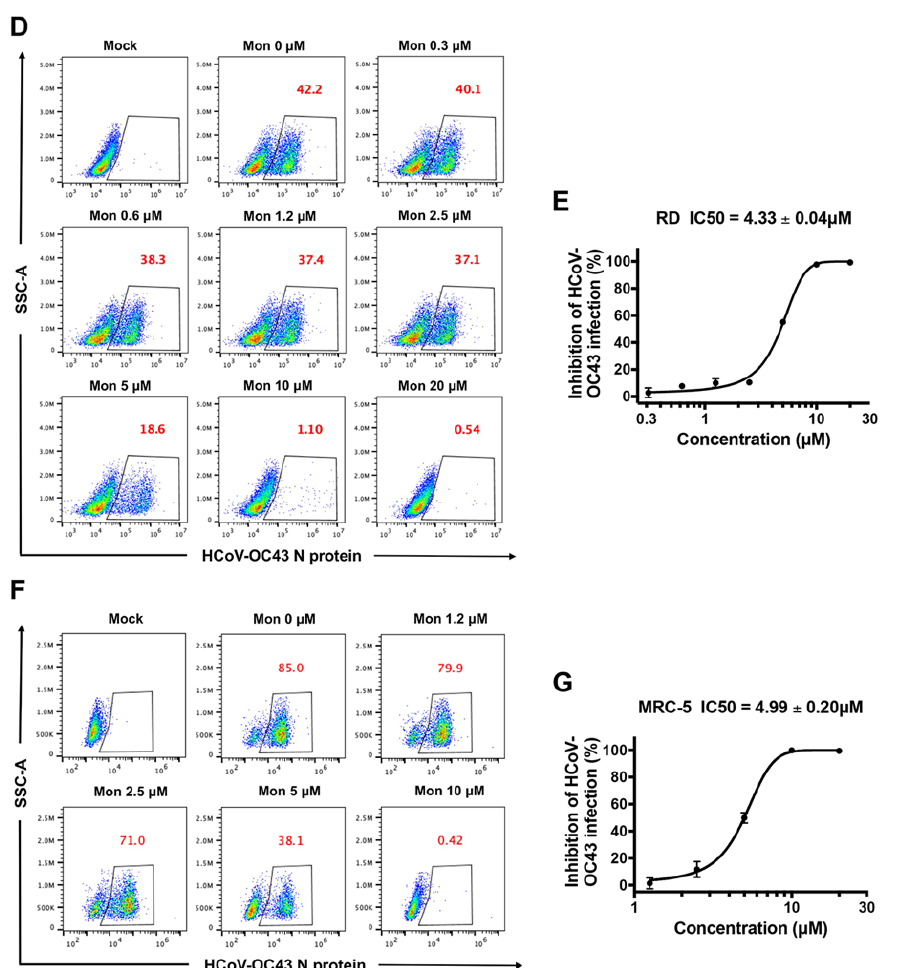
Figure 2. Inhibitory activity of montelukast (Mon) against HCoV-OC43 infection in a dose-dependent manner. Antiviral activity of montelukast against HCoV-OC43 in BHK-21 cells were measured by immunofluorescence assay ( A , B ) and in plaque reduction assay ( C ). HCoV-OC43 N protein were stained by the mouse anti-HCoV-OC43 nucleoprotein mAb (green); nuclei were stained by 4,6-diamidino-2-phenylindole (blue), scale bar: 25 µ m. RD cells were infected by HCoV-OC43 with serially diluted montelukast, then the percentage of infected cells (red numbers) was evaluated by flow cytometry and the 50% inhibitory concentration (IC50) value was calculated ( D , E ). MRC-5 cells were infected by HCoV-OC43 with serially diluted montelukast, the percentage of infected cells (red numbers) was evaluated by flow cytometry, and the IC50 value was calculated ( F , G ). Data are represented as means ± SD. NS, not significant; *** p < 0.001; **** p < 0.0001.